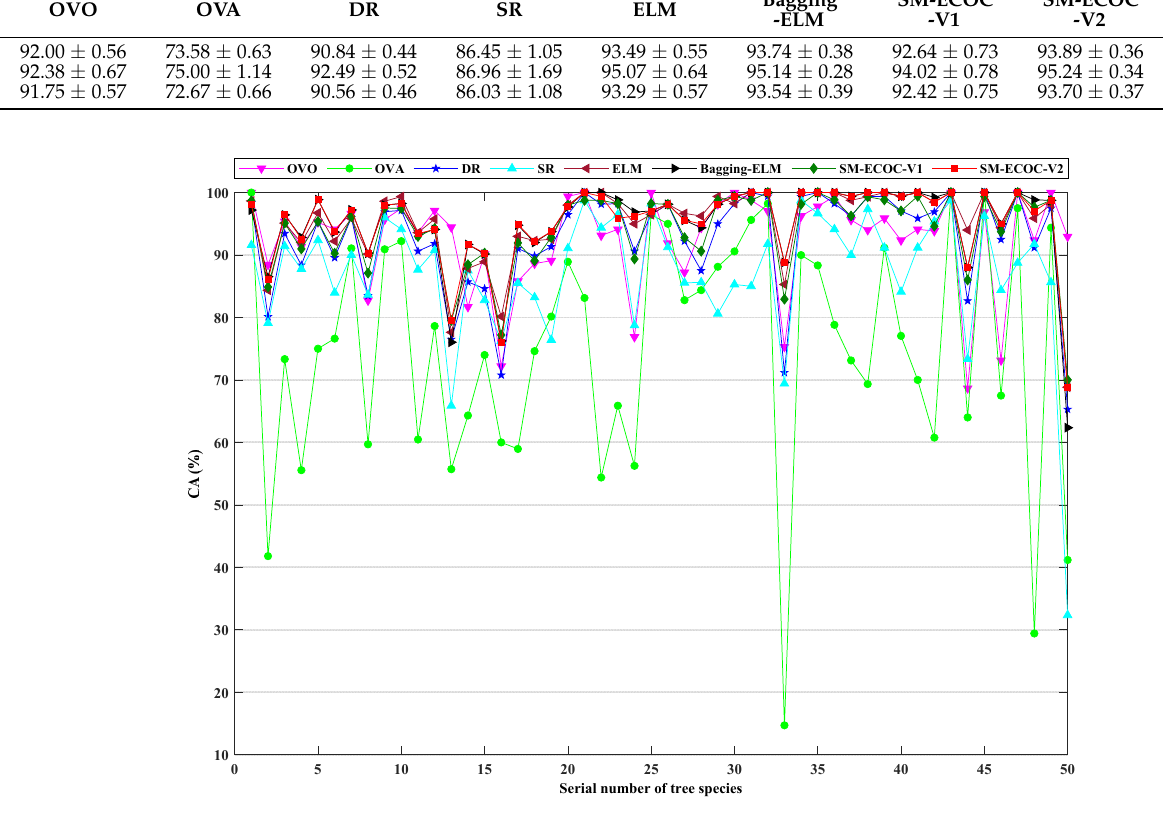
Figure 14. Class accuracy (%) of different classification models established based on feature bands.